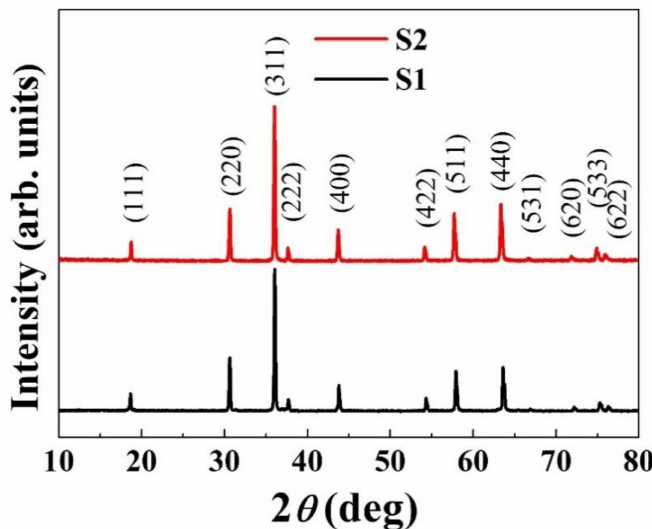
Figure 5. XRD patterns of sintered ceramics.